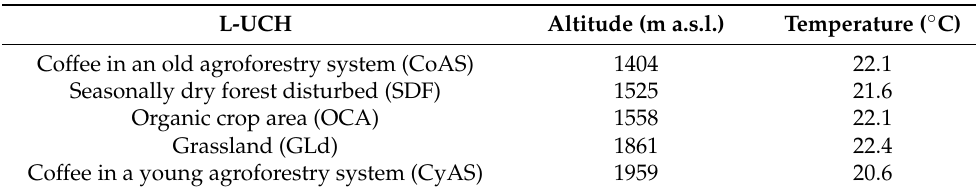
Table 1. Altitude of the different L-UCH classes and mean air temperature at each site during the whole study period (May 2019–February 2020). L-UCH Altitude (m